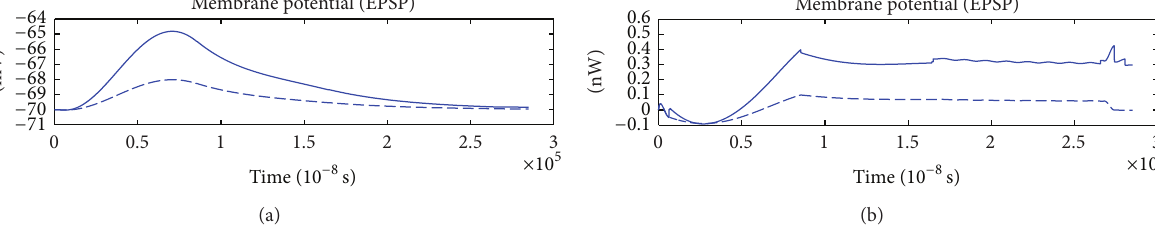
Figure 12: The EPSP and the corresponding energy function. 𝑟 0𝑚 = 0.0001 Ω , 𝑟 1𝑚 = 0.1 Ω , 𝑟 2𝑚 = 1000 Ω , 𝑟 3𝑚 = 0.1Ω , 𝑟 𝑚 = 1000 Ω , = 1 𝜇 F, 𝐿 = 50 𝜇 H, 𝑖 = 7.155 𝜇 A, and 𝑄 = 1 × 10 −5 𝜇 A. 𝐶 𝑚 𝑚 0𝑚